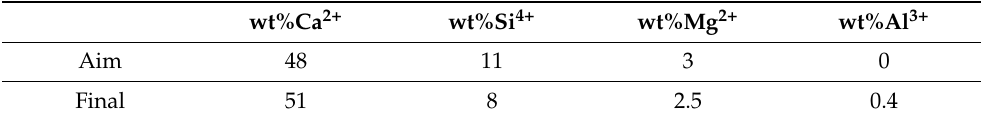
Table 3. XRF analysis results (as cation wt%) of oxide slag before and after the